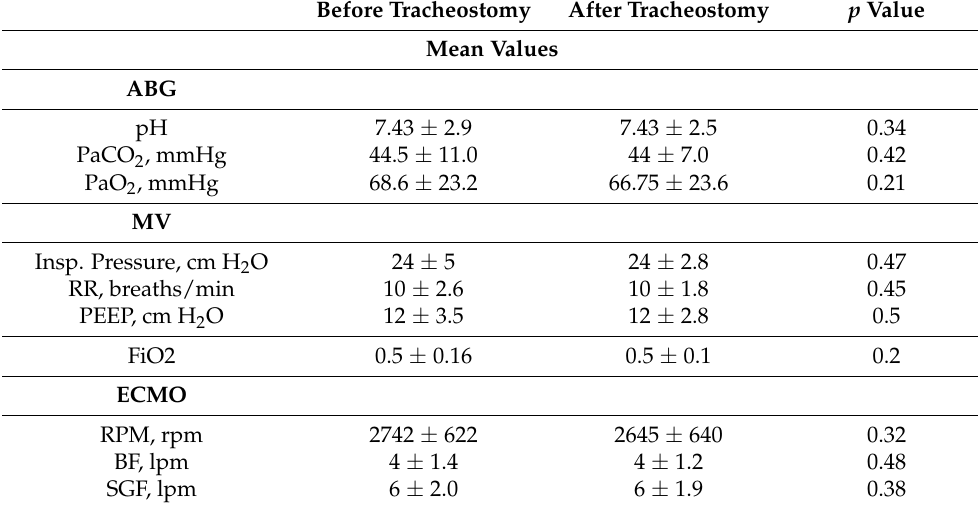
Table 2. Arterial blood gas analyses, mechanical ventilation, and ECMO data before and after apneic tracheostomy (where ABG: arterial blood gas analyses; PaCO 2 : arterial partial pressure of carbon dioxide; PaO 2 : arterial partial pressure of oxygen; MV: mechanical ventilation; Pinsp: inspiratory pressure; RR: respiratory rate; PEEP: positive end-expiratory pressure; FiO 2 : inspiratory oxygen fraction; RPM: round per minute; BF: ECMO blood flow; SGF: ECMO sweep gas flow). p Values refer to paired t